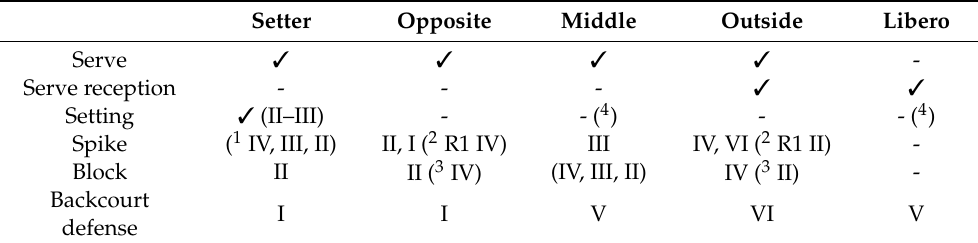
Table 4. Player’s role and subsequent tasks in volleyball according to their